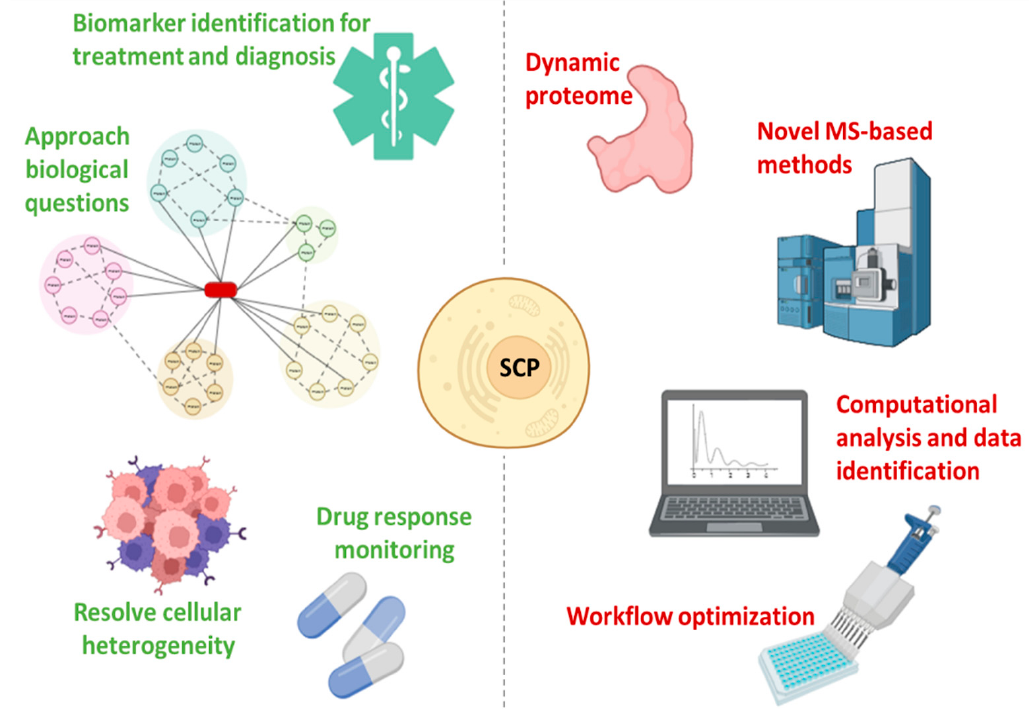
Figure 4. Advantages (green) and challenges (red) in single-cell proteomics.